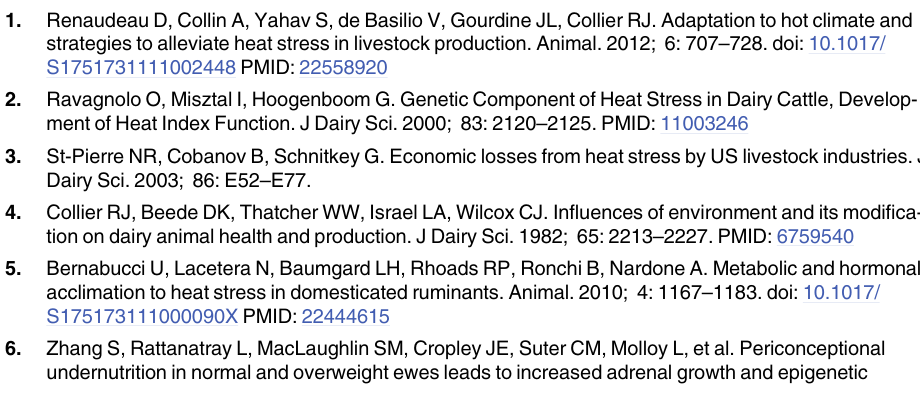
S1 Fig. Frequency histogram of mature-equivalent milk produced by Georgia cattle by sea- son of calving and heat stress category. S2 Fig. Normal QQ-plots of studentized residuals for linear mixed models by state.